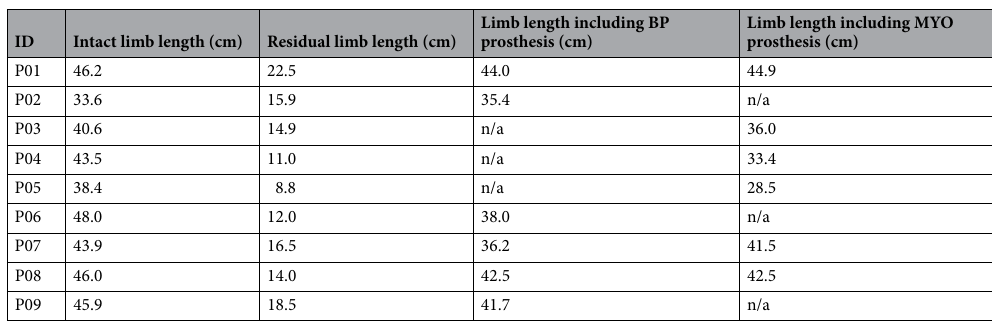
Table 2. Limb lengths for prosthesis